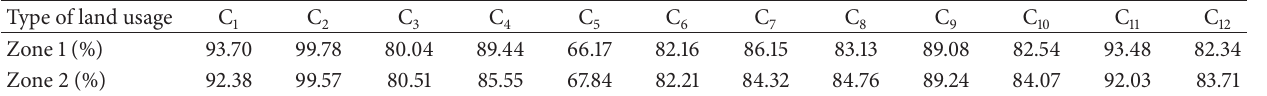
Table 9: Land usage classification accuracy (zone